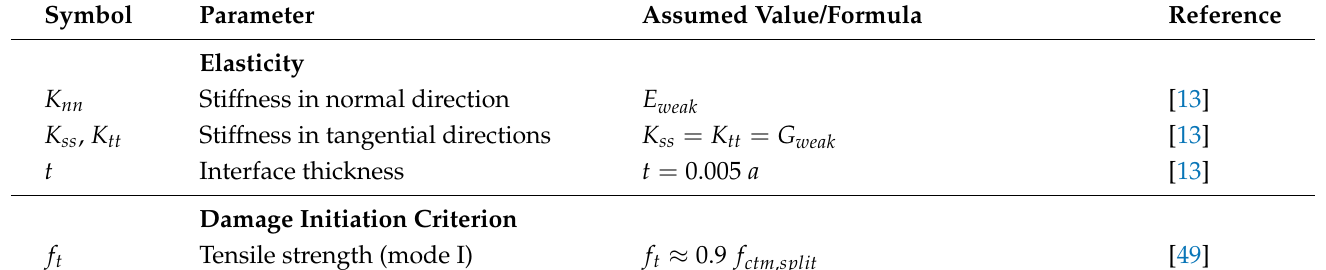
Table 7. The calibration of a traction–separation model for a concrete-to-concrete interface—main assumptions. Symbol